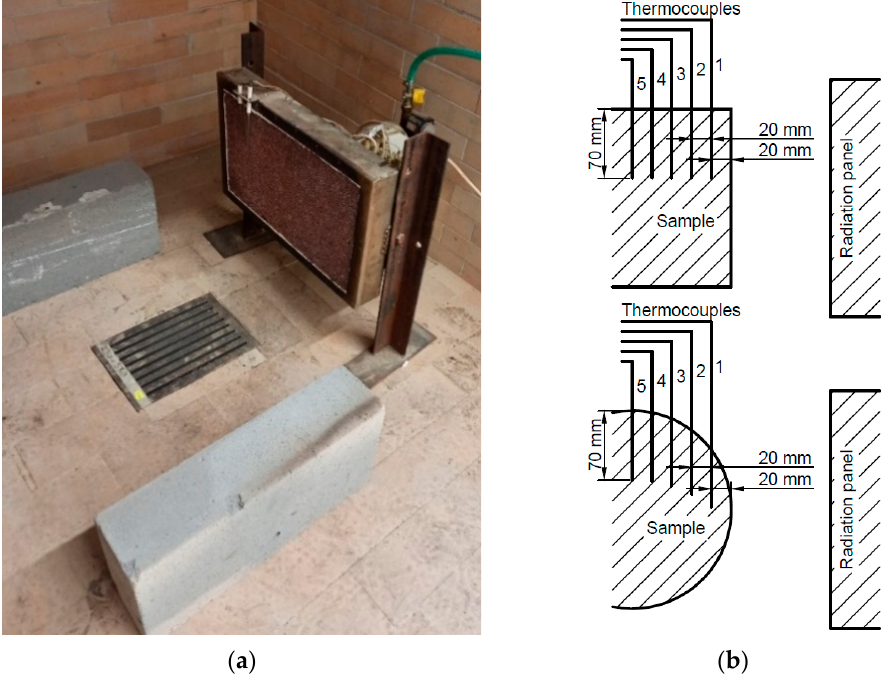
Figure 3. ( a ) Assembly for medium-scale fire test; ( b ) location of thermocouples in the test